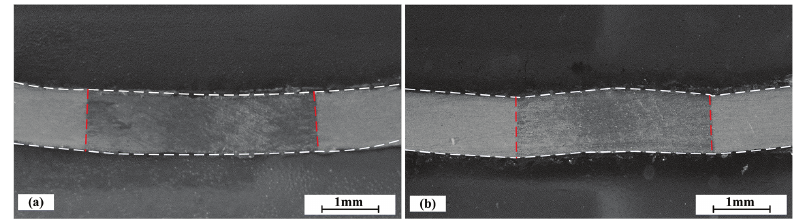
Figure 14: Weld stereomicroscope images under different gas flow rates of (a) sheet No. 1 and (b) sheet No. 9.